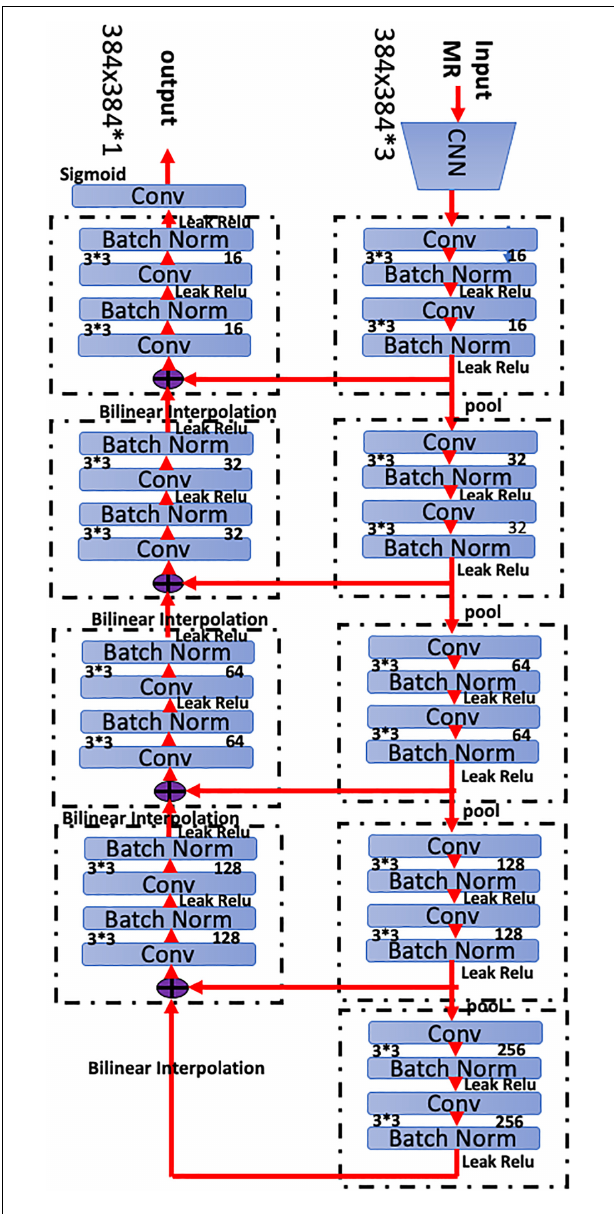
FIGURE 1 | Network architecture of the proposed three-dimensional (3D) convolutional neural network (CNN). The network has 28 layers integrating six residual blocks. Bilinear interpolating arrows indicate upsampling operations to provide dense predictions for the segmentation task. Skip connections are used to fuse low- and high-level features in the network. Batch normalization is a linear transformation of the features to reduce covariance shift and accelerate the training process. The convolution bar represents the convolution operation that computes features. The number 64 indicates the number of channels in that layer, and 3 3 3 3 3 denotes the size of the 3D CNN